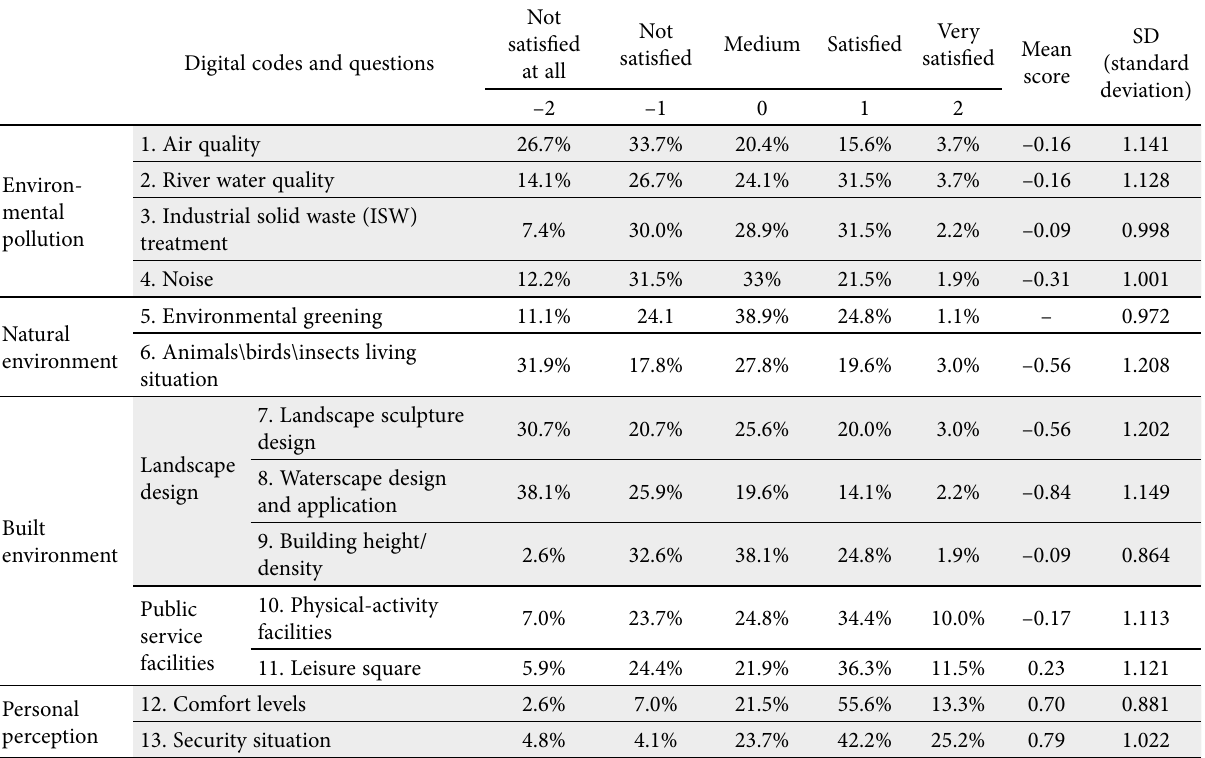
Table 2. Interviewees’ evaluation of the industrial corridor environmental quality